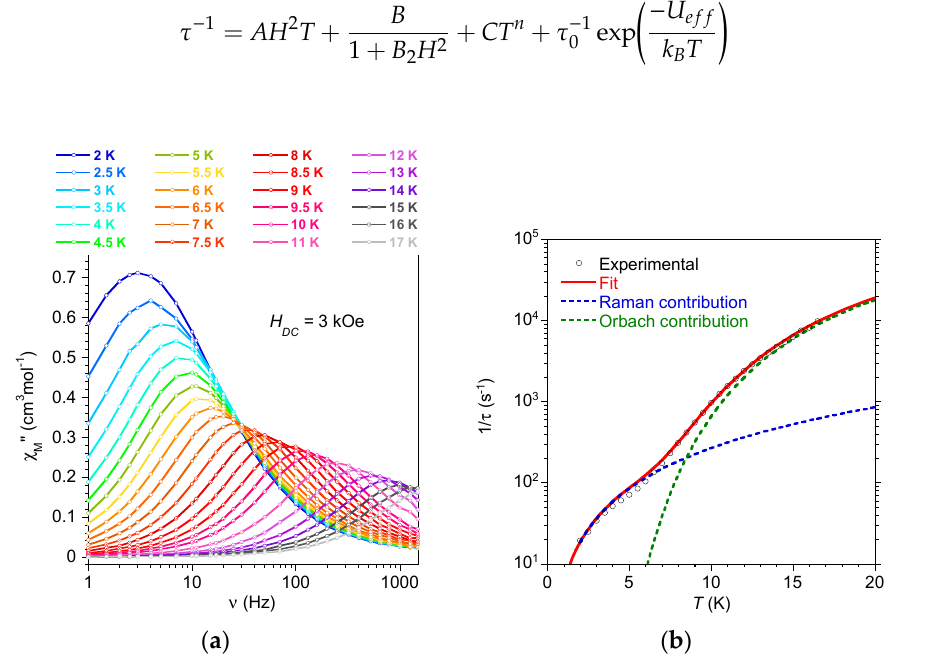
Figure 3. ( a ) Frequency dependence of the out-of-phase component of the AC susceptibility of 1 with an applied field of 3 kOe, and ( b ) temperature dependence of its relaxation time with the best fit ( — ) for a combination of Raman, and Orbach contributions, and (---) their calculated individual contributions.